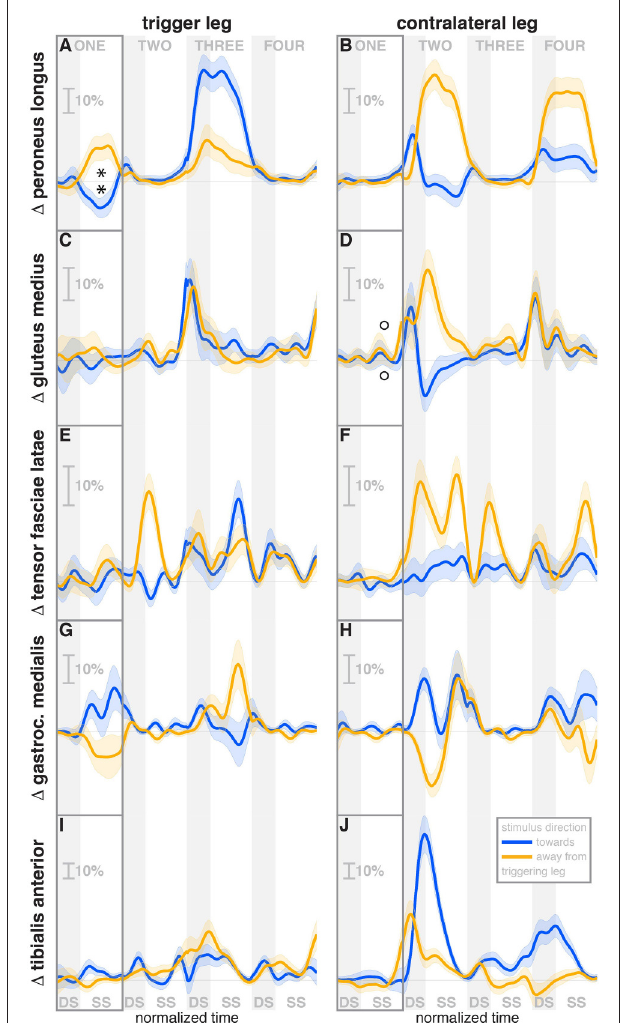
FIGURE 4 | Changes in response to the visual stimulus in leg joint kinematics. The baseline represents the average of the control steps. Curves start at the heelstrike triggering the stimulus and show the subsequent four steps in normalized time, with the first step marked for clarity. Blue curves correspond to fall stimuli toward the triggering leg, orange curves to fall stimuli away from the triggering leg. Asterisks indicate statistically significant difference from zero, circles indicate lack of statistically significant difference from zero (see Table 3 ). Lack of marks indicate that no hypothesis was statistically tested. The shaded areas are 95% confidence intervals calculated using simplifying assumptions (see Methods).